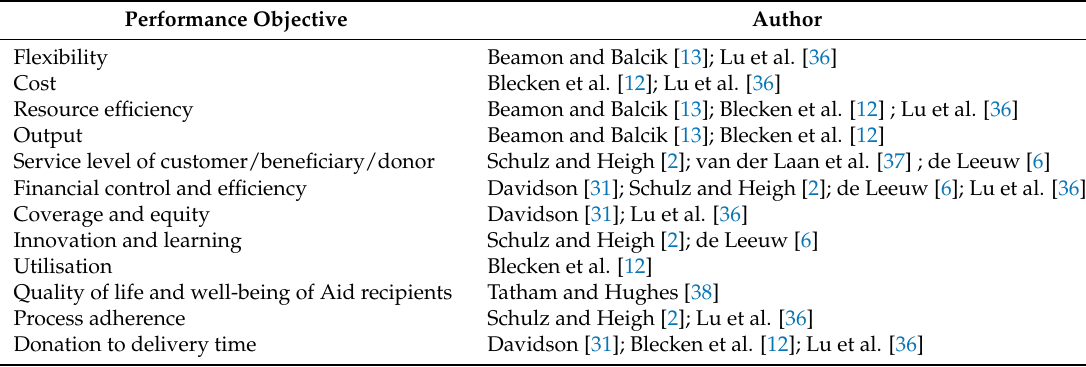
Table 1. Performance objectives of humanitarian supply